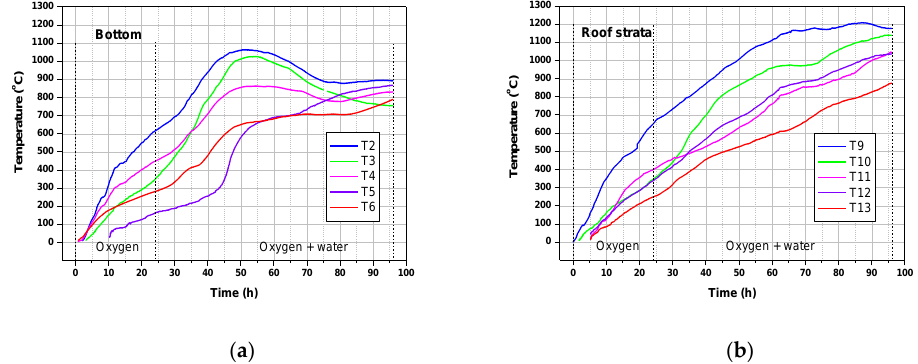
Figure 10. Distributions of temperatures during “Six Feet” semi-anthracite gasification at 20 bar: ( a ) seam bottom, ( b ) roof strata.